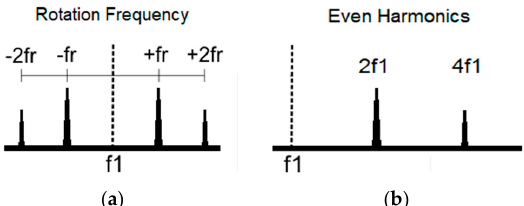
Figure 1. Fault patterns: ( a ) rotor rotation frequency (pattern for rotor winding inter-turn short circuit— electrical fault, and for rotor mechanical faults); ( b ) even harmonics (pattern for rotor winding inter-turn short circuit—electrical fault).